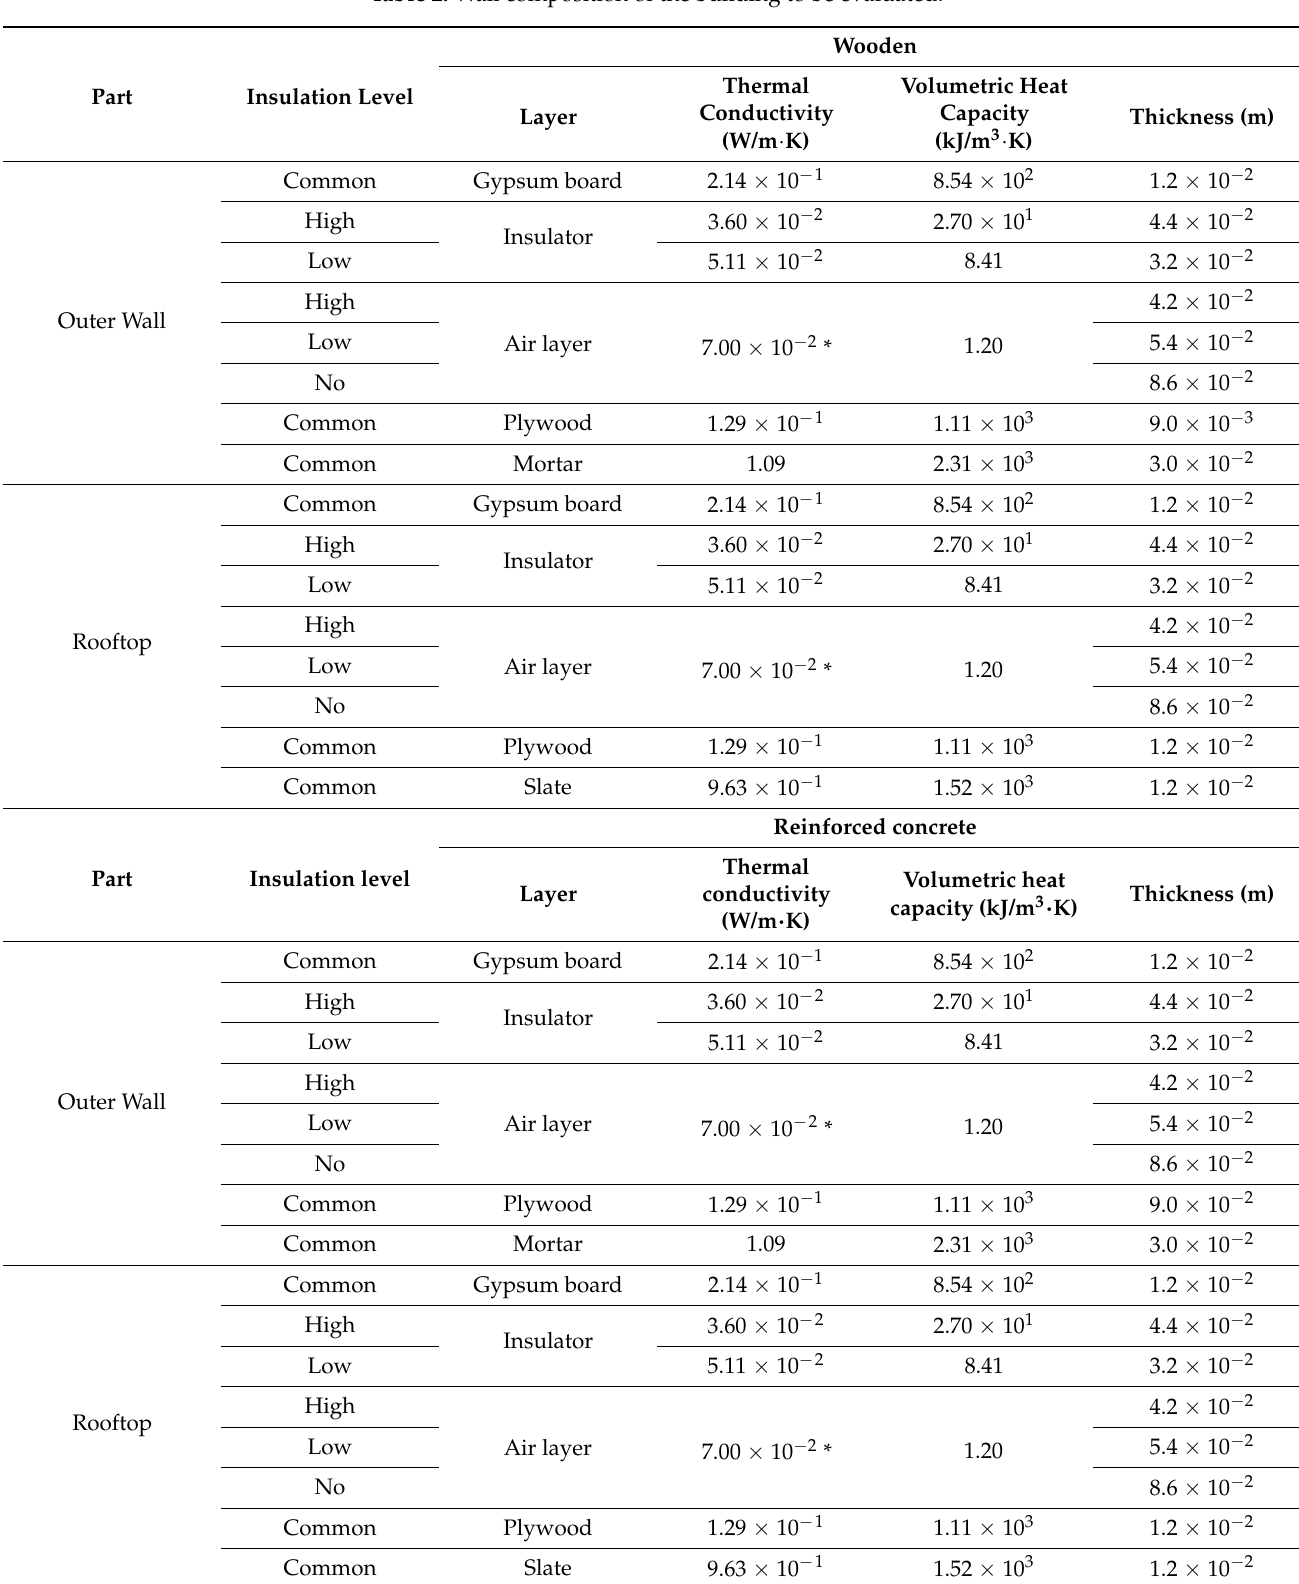
Table 2. Wall composition of the building to be